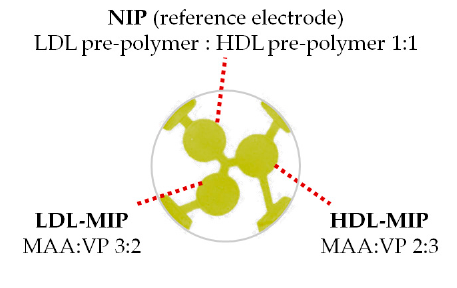
Figure 1. A scheme diagram for lipoproteins sensor array based on three-electrode